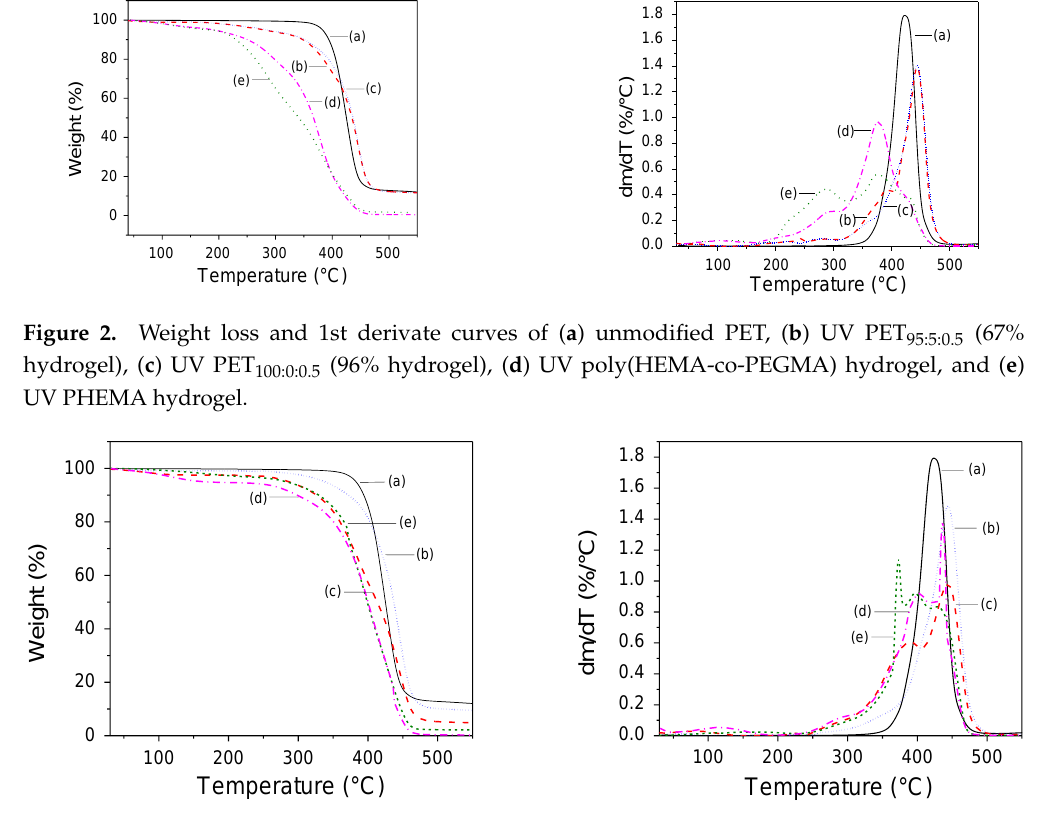
Figure 3. TGA curves of ( a ) unmodified PET, ( b ) γ 60 PET 100:0:50 (257% hydrogel), ( c ) γ 60 PHEMA hydrogel, ( d ) γ 60 PET 90:10:50 (400% hydrogel), and ( e ) γ 60 poly (HEMA-co-PEGMA) hydrogel.